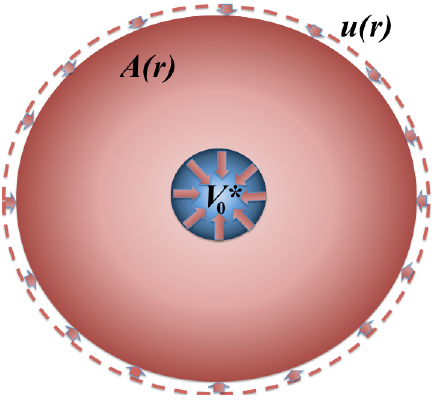
Figure 5: When a certain amount of volume V ∗ elastic medium it leads to a displacement u ( r ) = − V ∗